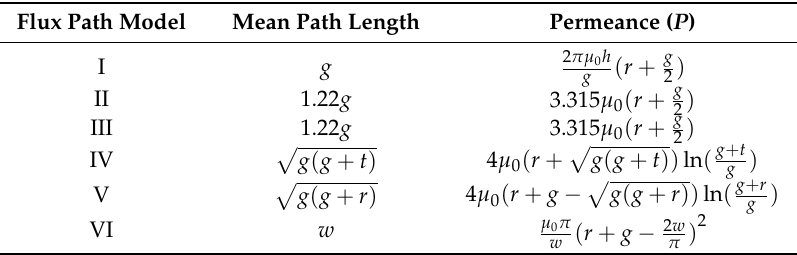
Table 1. The air gaps flux path model calculations.